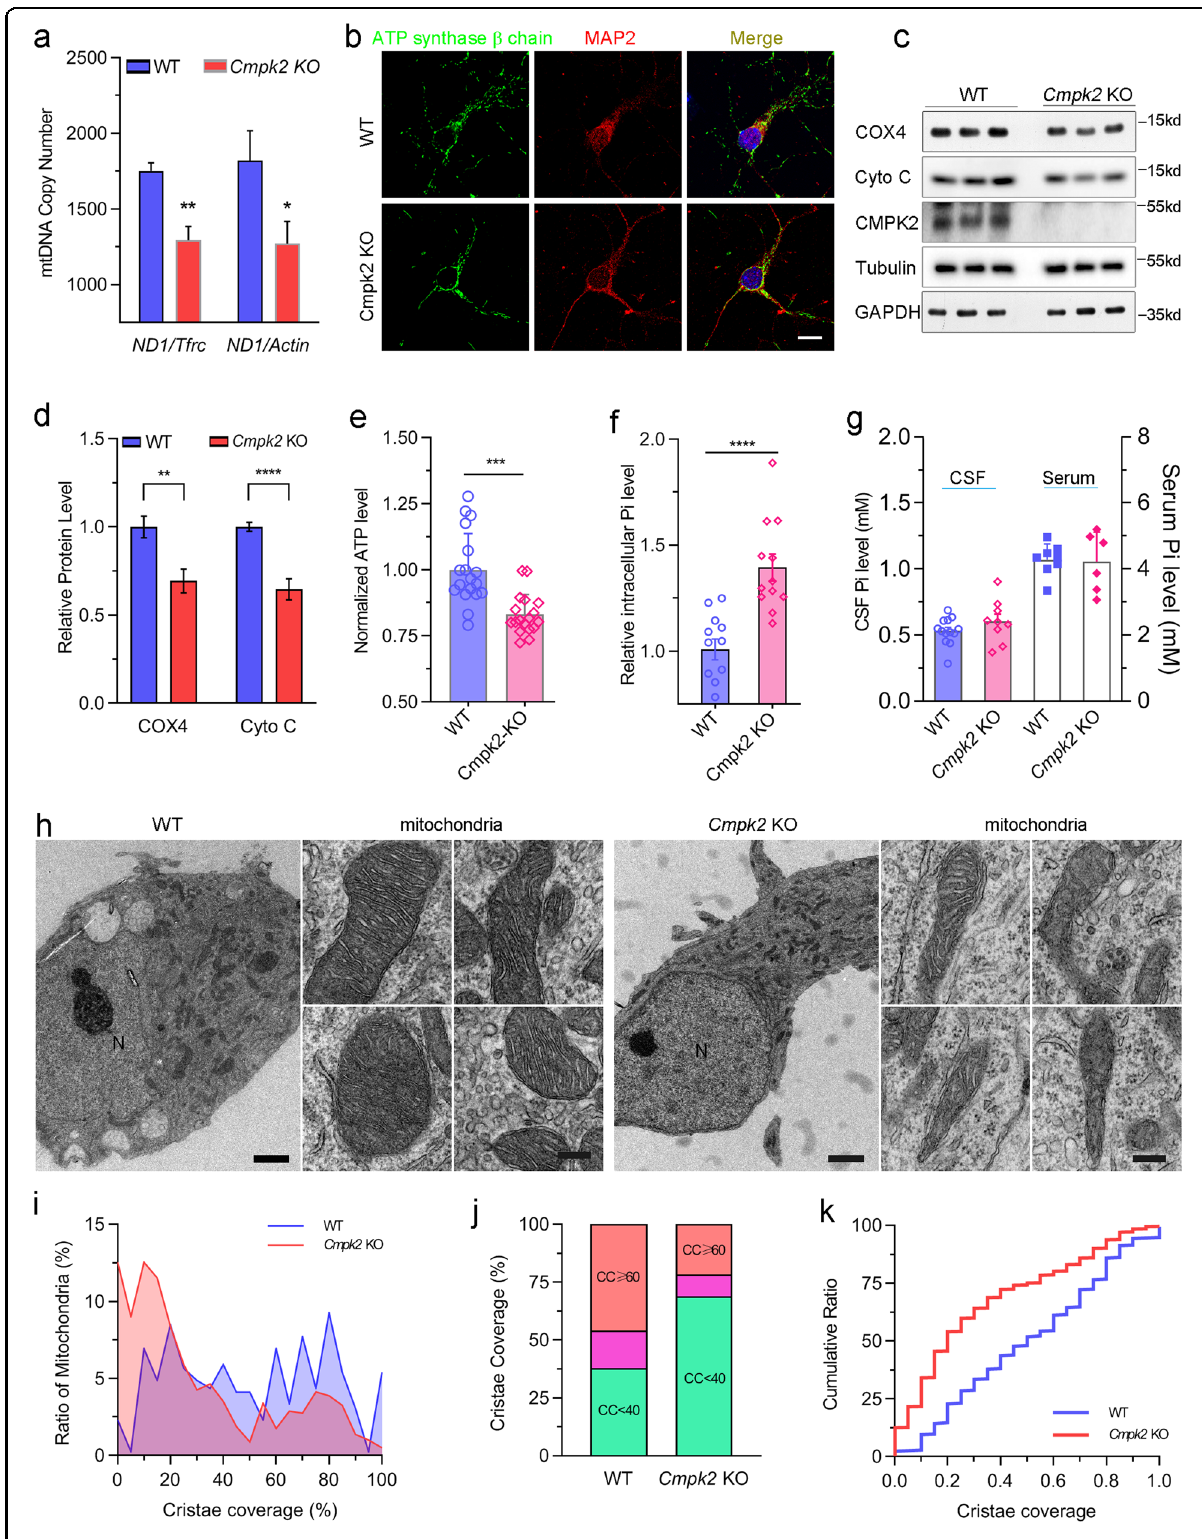
Fig. 4 (See legend on next